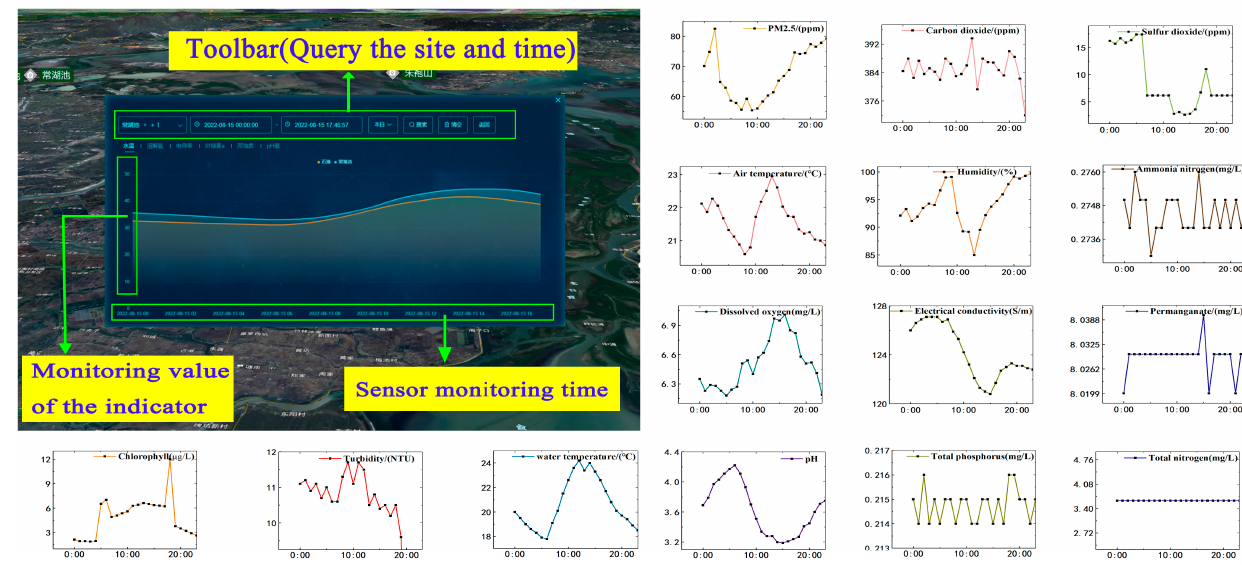
Figure 6. Display of multi-dimensional temporal changes in monitoring data.